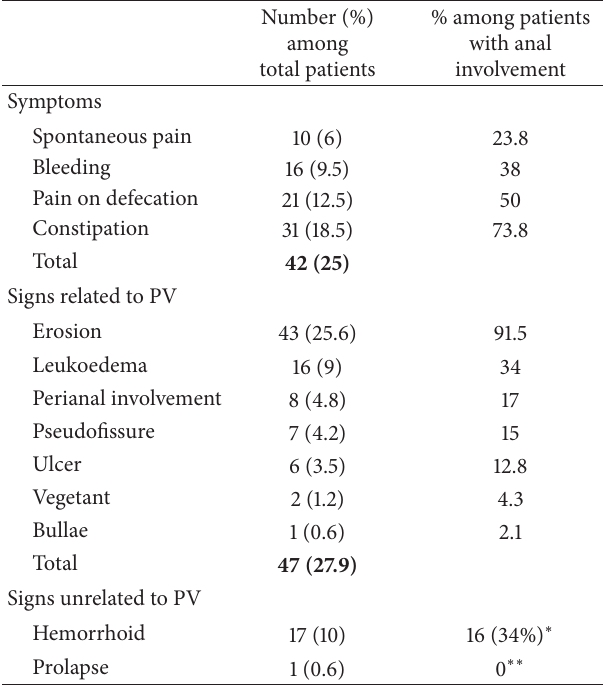
Table 2: Symptoms and signs in patients with pemphigus